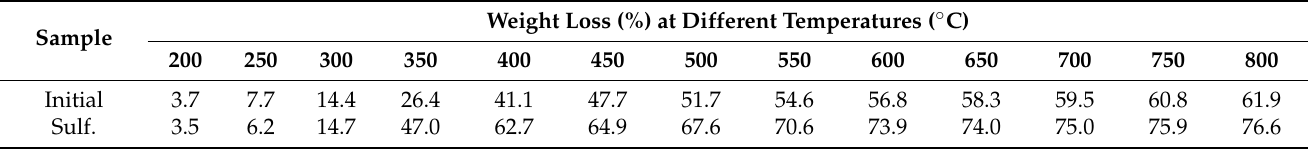
Table 2. Main ranges of thermal decomposition of lignins upon heating at a rate of 10 deg/min.